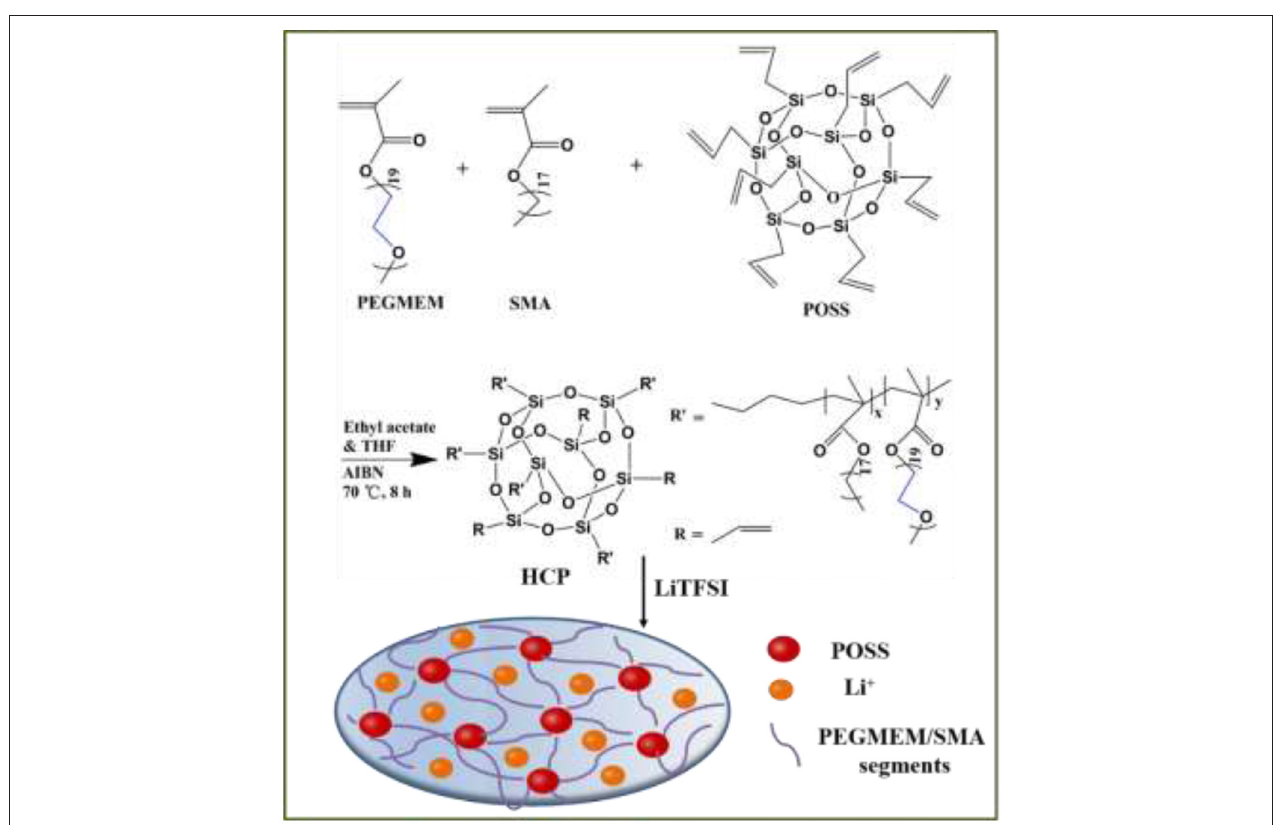
SCHEME 1 | Synthesis of freestanding cross-linked HPE